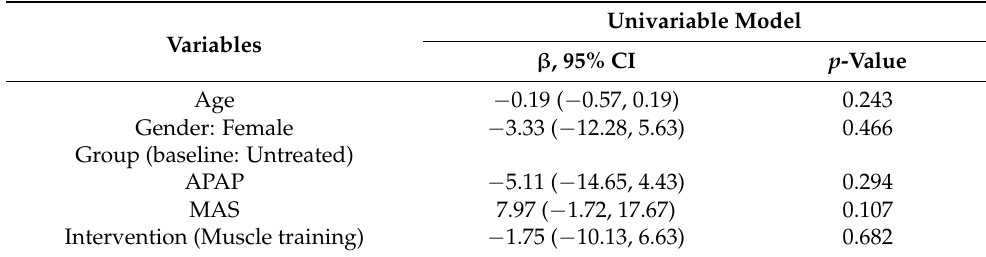
Table 3. Factors Contributing to the Change of AHI over time by Mixed Model Analysis.